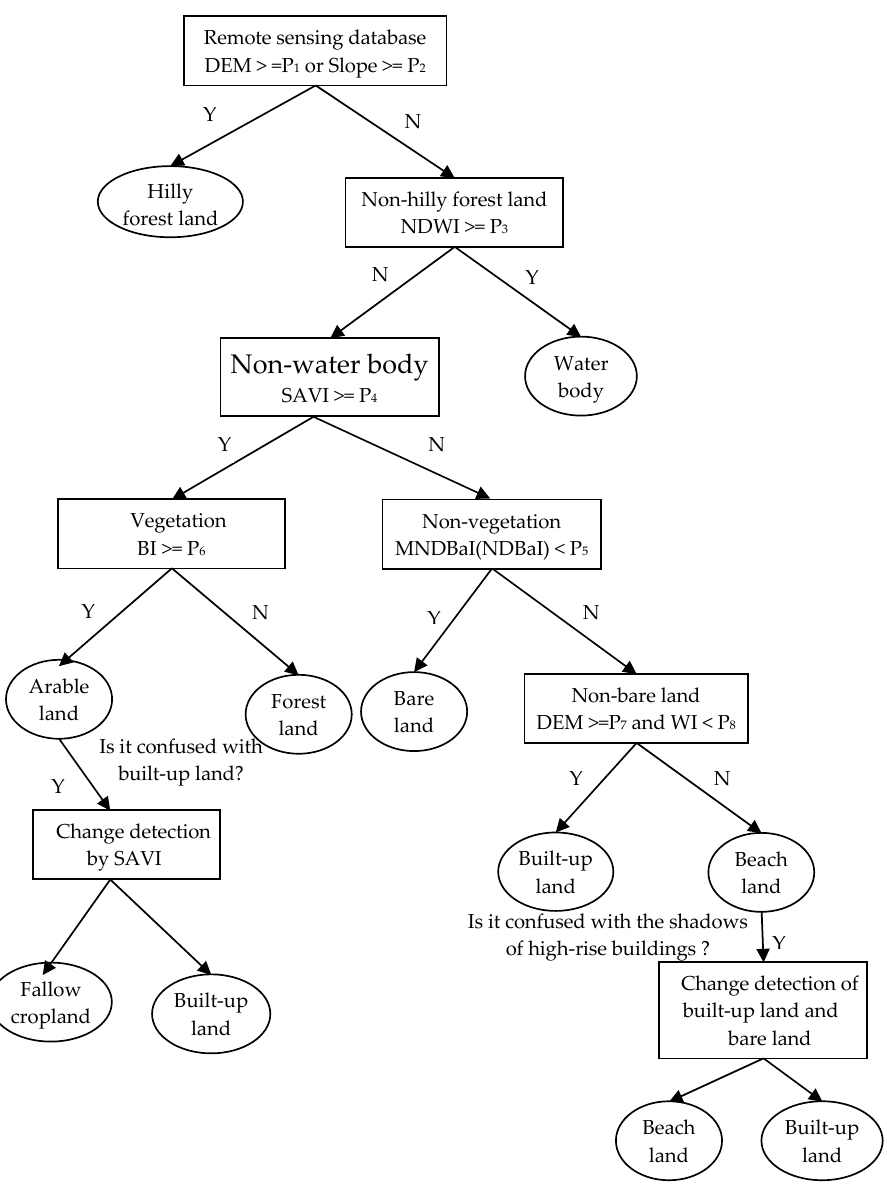
Figure 3. Feature-based approach of decision tree classification constructed to extract urban LULC using Landsat 5 TM and Landsat 8 OLI data (see Figure 2 for key to abbreviations).